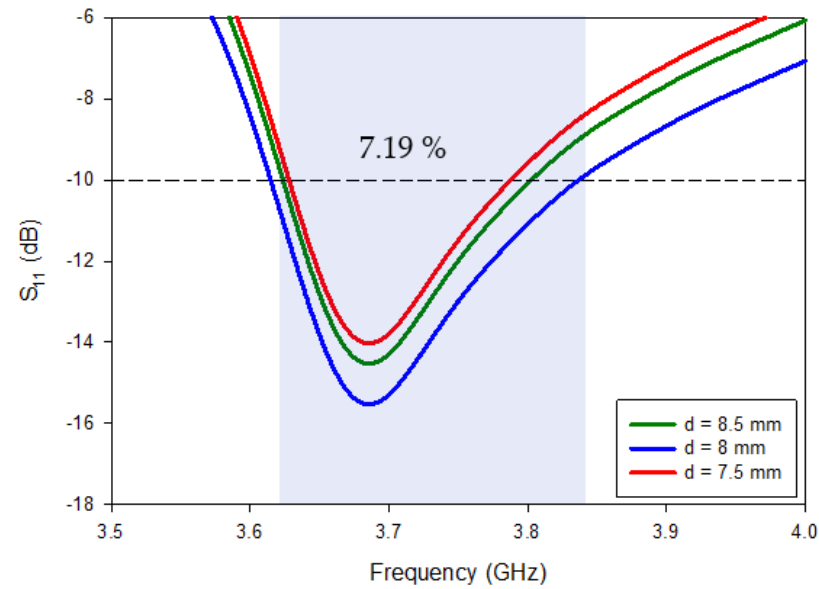
Figure 3. S 11 of the RDRA feed at various distances from the edge.